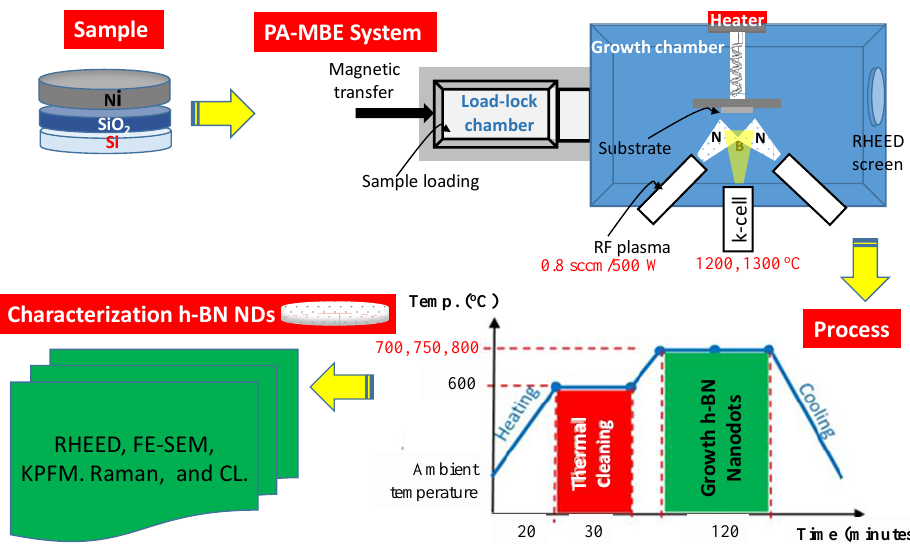
Figure 1. Schematic of the preparation and characterizations of h-BN QDs.